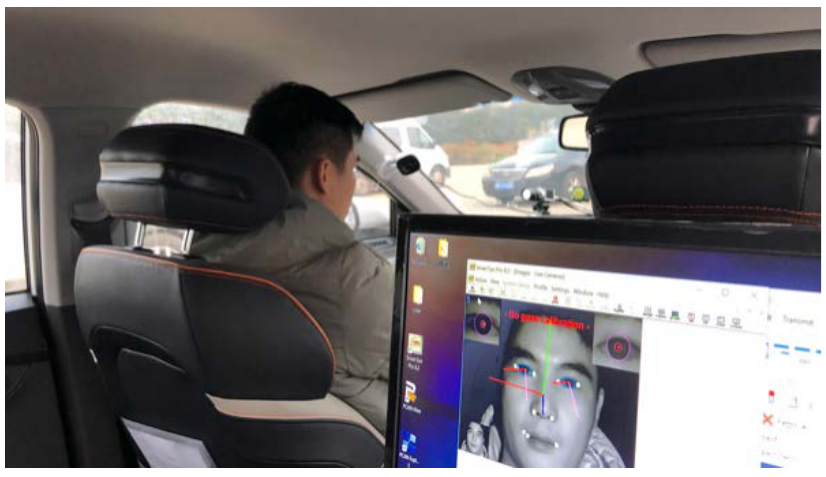
Figure 2. Experimental setup.